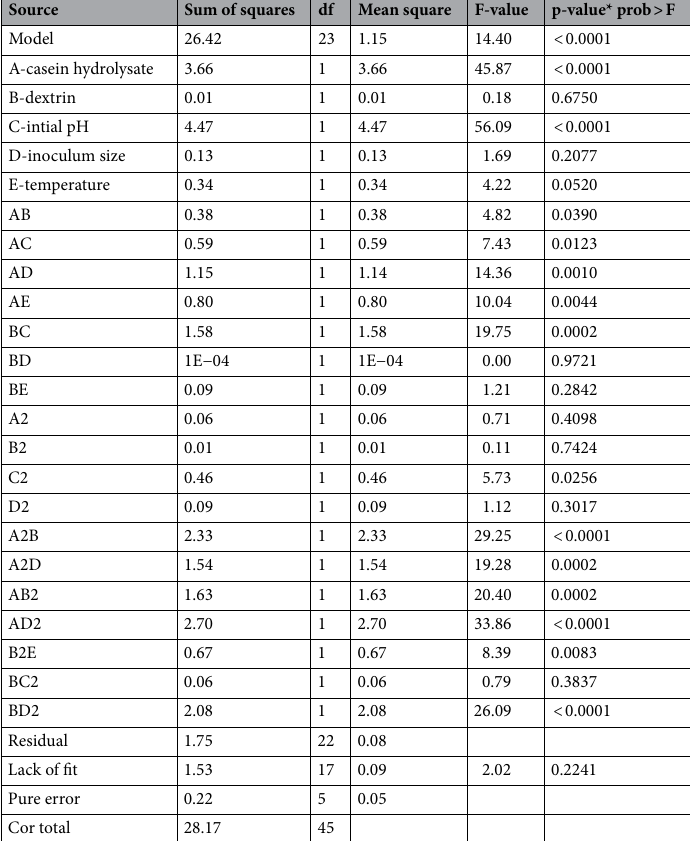
Table 8. Analysis of variance (ANOVA) of BBD of AuNPs biosynthesis, using the extracellular filtrate of Bacillus subtilis NRC1. F value = 14.40; R 2 = 0.94; Adjusted R 2 = 0.87. *: Values of "prob > F" less than 0.05 indicate model terms are